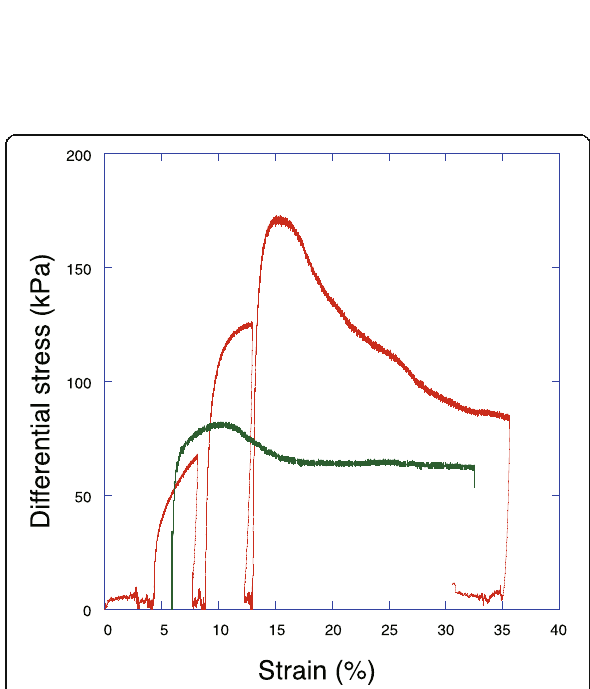
Fig. 4 Differential stress/strain curves for single compression test (dark green) and pressure stepping test (red) from sample